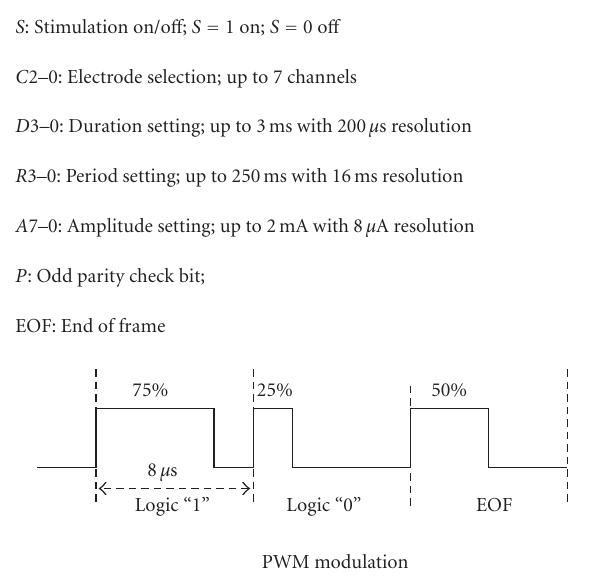
Figure 2: Data formats and PWM